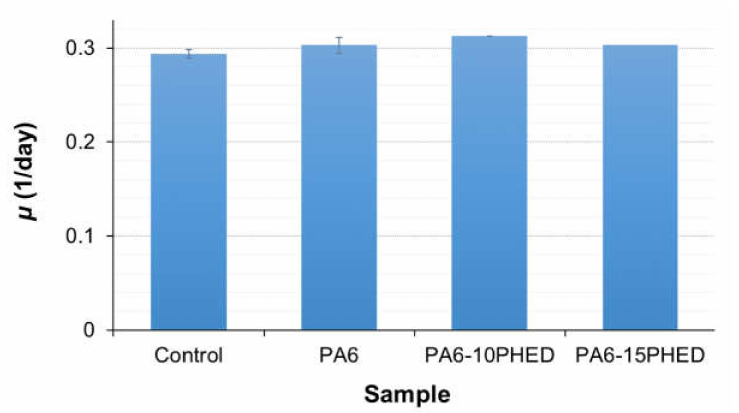
Figure 11. The average specific growth rate of the L. minor grown in the control and PA6, PA6/10PHED, and PA6/15 PHD leachates. The error bars represent the standard error of the